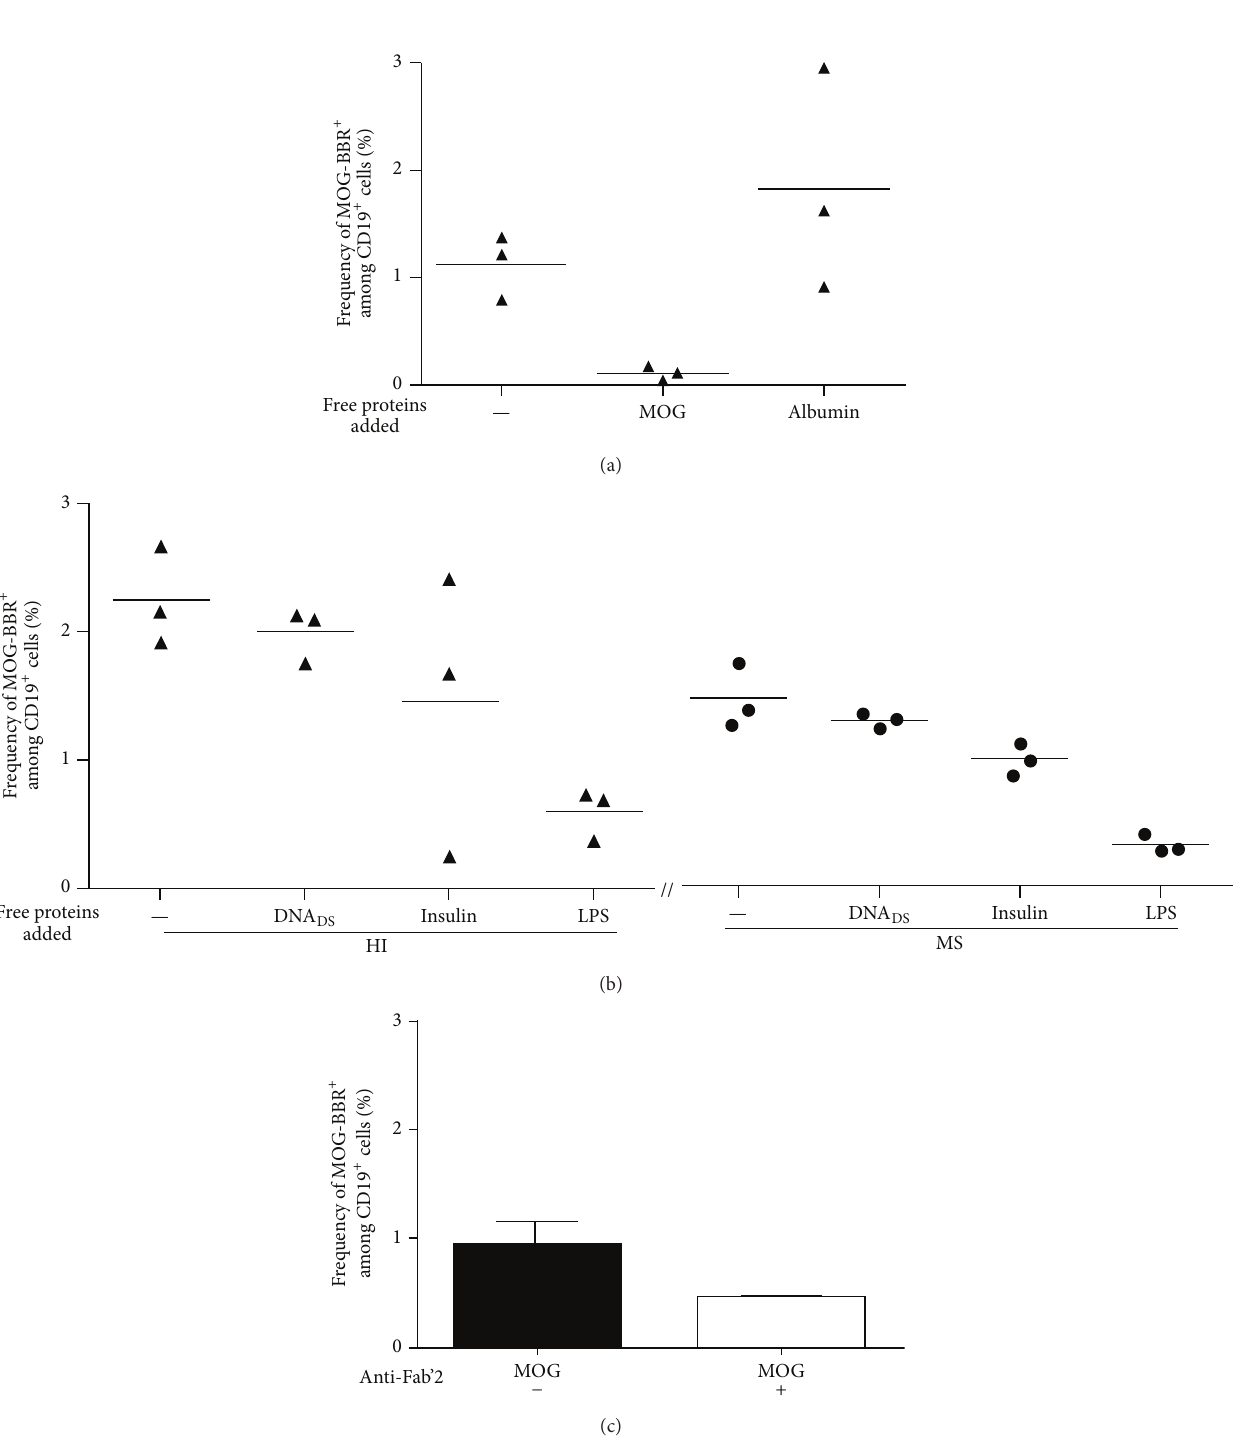
Figure 2: Reactivity of MOG-specific B cells. B cells were preincubated with 20 𝜇 g of soluble MOG, albumin, dsDNA, insulin, or LPS before the addition of MOG-coated beads ( 𝑛 = 3 ). (a) The frequency of MOG-BBR drops with the soluble MOG preincubation but not with albumin preincubation. (b) The recognition of MOG-coated beads decreased after the addition of soluble LPS (% of inhibition: 73%), dsDNA (11%), and insulin (35%). Competitive assay was tested in MS ( 𝑛 = 3 ); the percentage of inhibition after soluble antigen addition was the same proportion as HI: LPS (78%), dsDNA (11%), and insulin (32%). (c) B cells were preincubated with Fab’2 anti-human IgG+IgA+IgM. The frequency of B cells recognizing MOG-coated beads was assessed on 3 HI. Fab’2 antibody modified the frequency of MOG-specific B cells (ns, 𝑃 > 0.05 , Wilcoxon test